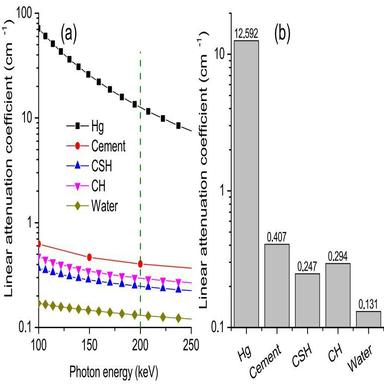
(a) X-ray LACs of mercury, cement, CSH, CH and water versus photon energy (100–250 keV), and (b) LAC values at the photon energy of 200 keV.